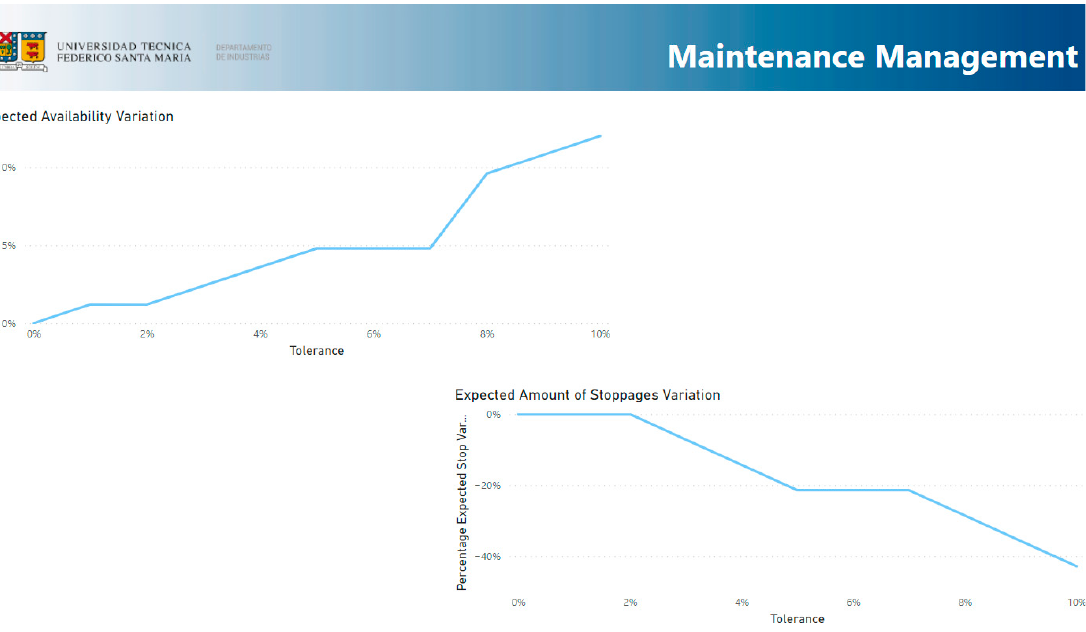
Figure 6. Maintenance management